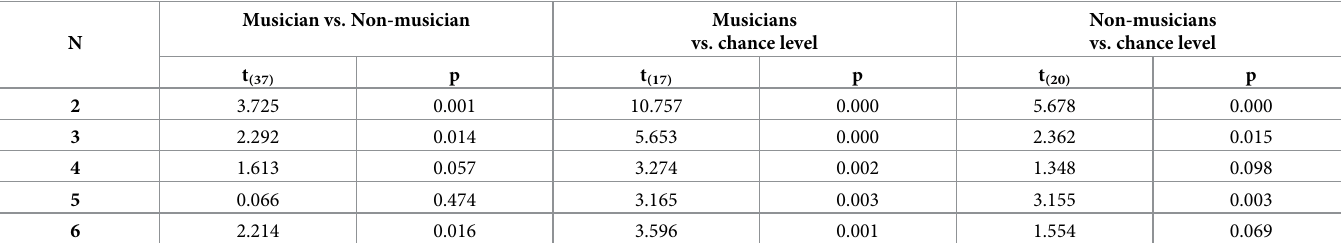
Table 1. t-test analysis for Experiment 2.